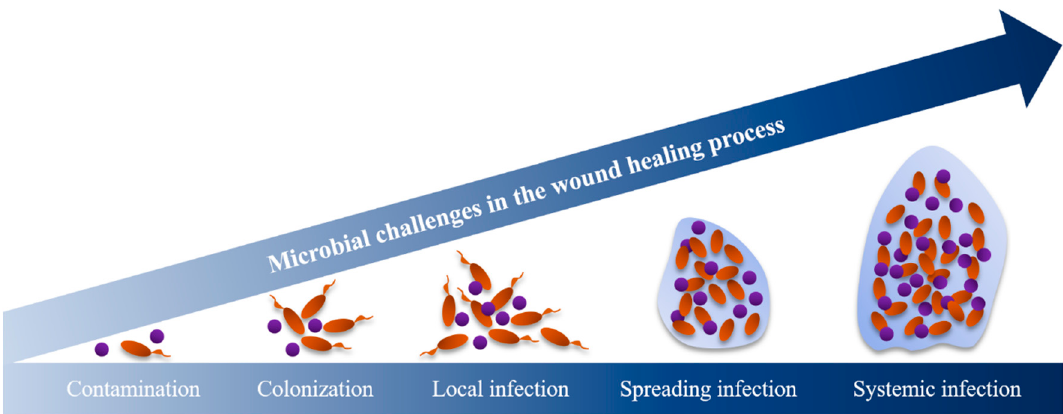
Figure 3. The wound infection continuum [18,30].